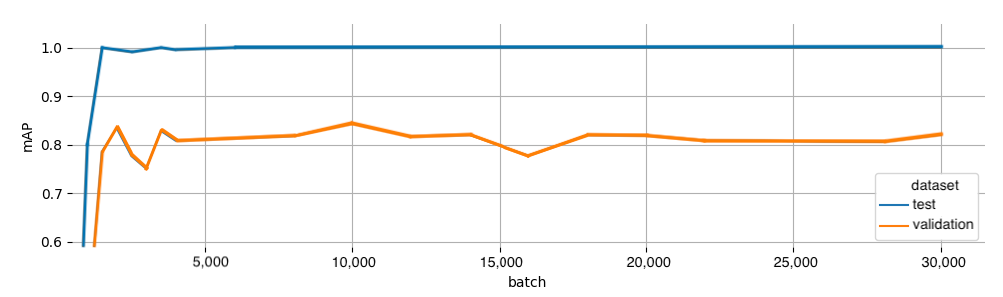
Figure 8. (Orange) mAP for the test set. (Blue) mAP for the validation